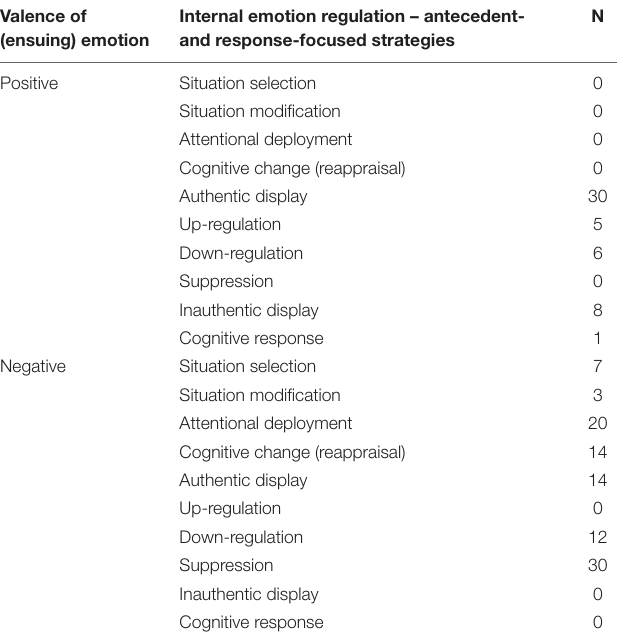
TABLE 2 | Internal emotion regulation strategies and absolute number of team